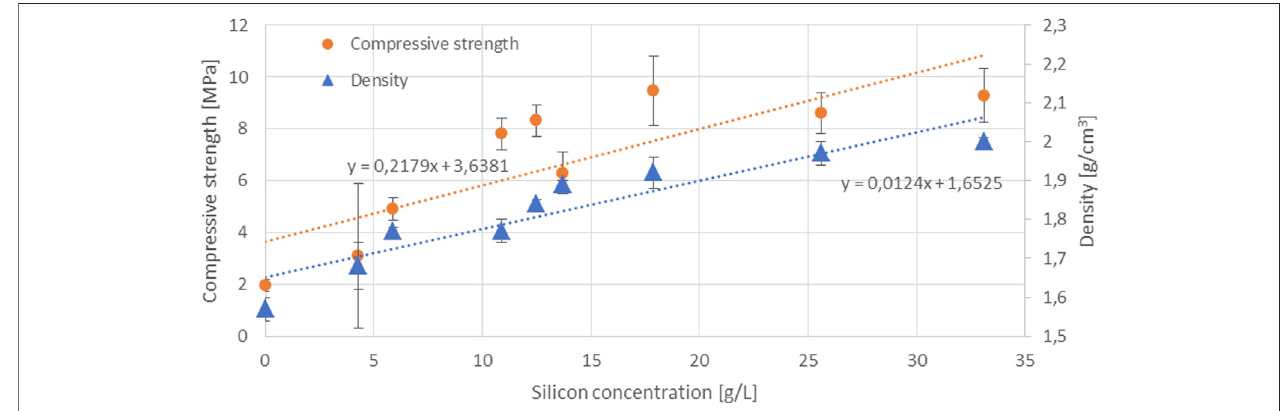
FIGURE3| CompressivestrengthanddensityofthehardenedsamplesasafunctionoftheSiconcentrationintheAAAs(circlesdenotecompressivestrengthand triangles denote density).